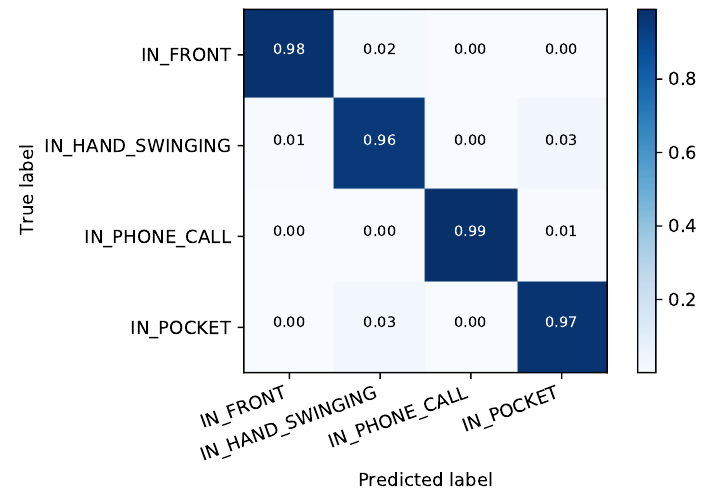
Figure 7. Classification accuracy for the device placement